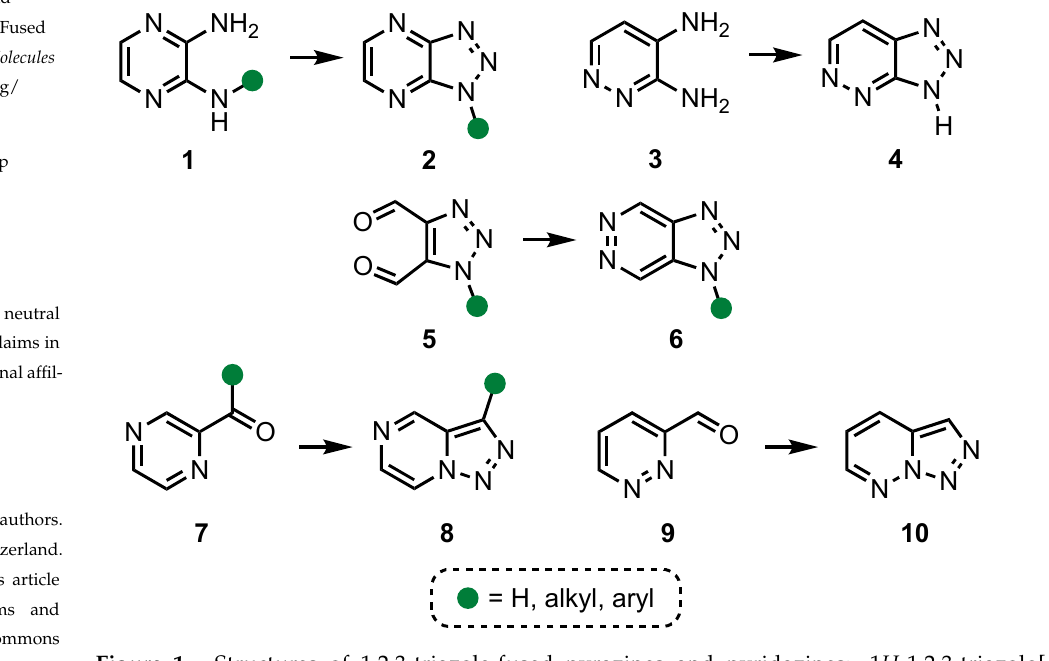
Figure 1. Structures of 1,2,3-triazole-fused pyrazines and pyridazines: 1 H -1,2,3-triazolo[4,5- b ]pyra-